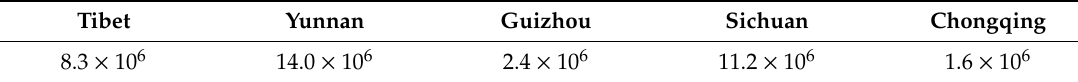
Table 4. Forest area size of each province in Southwest China in 2017 (unit: